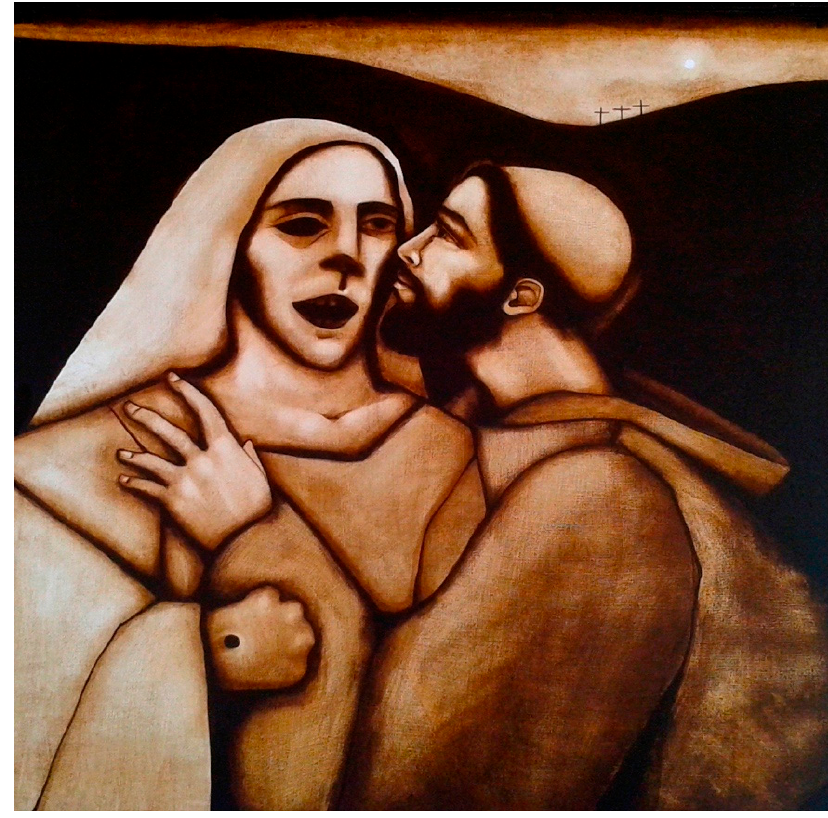
Figure 3. St. Francis Embracing the